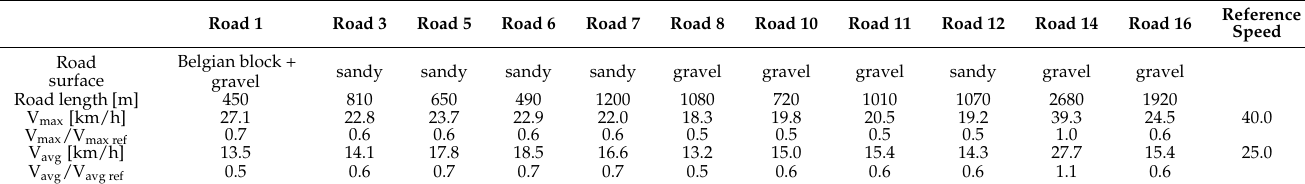
Table 4. Speeds on selected off-road class test road